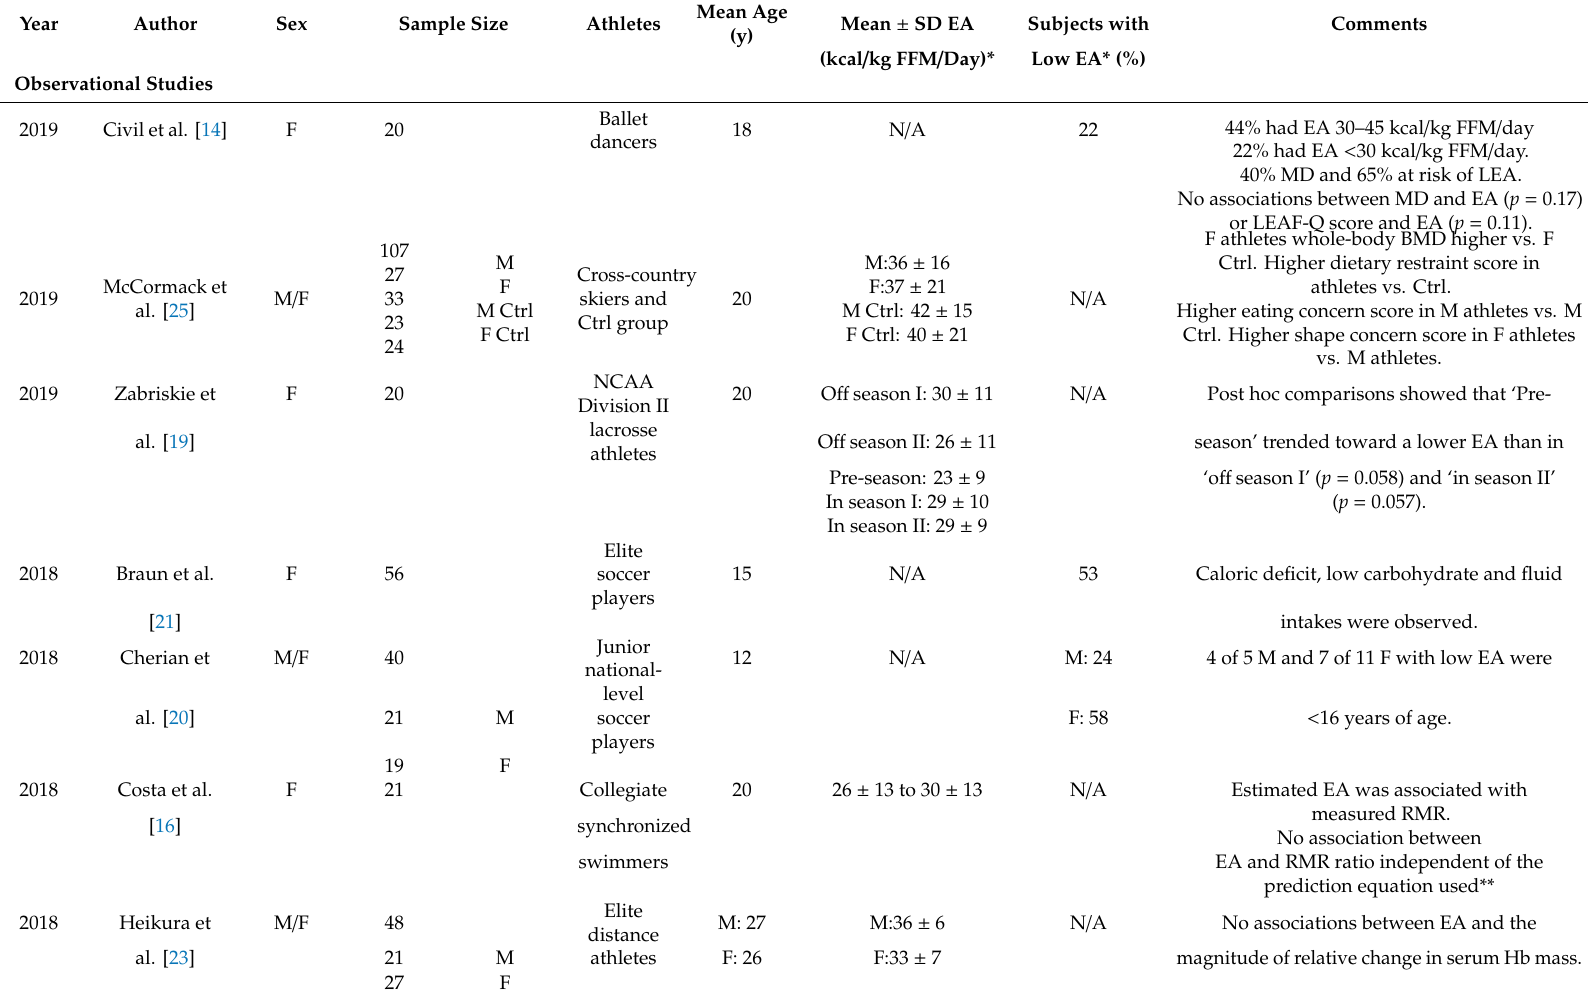
Table 1. Estimated prevalence of low energy availability in various sport groups (Jan 2017–May